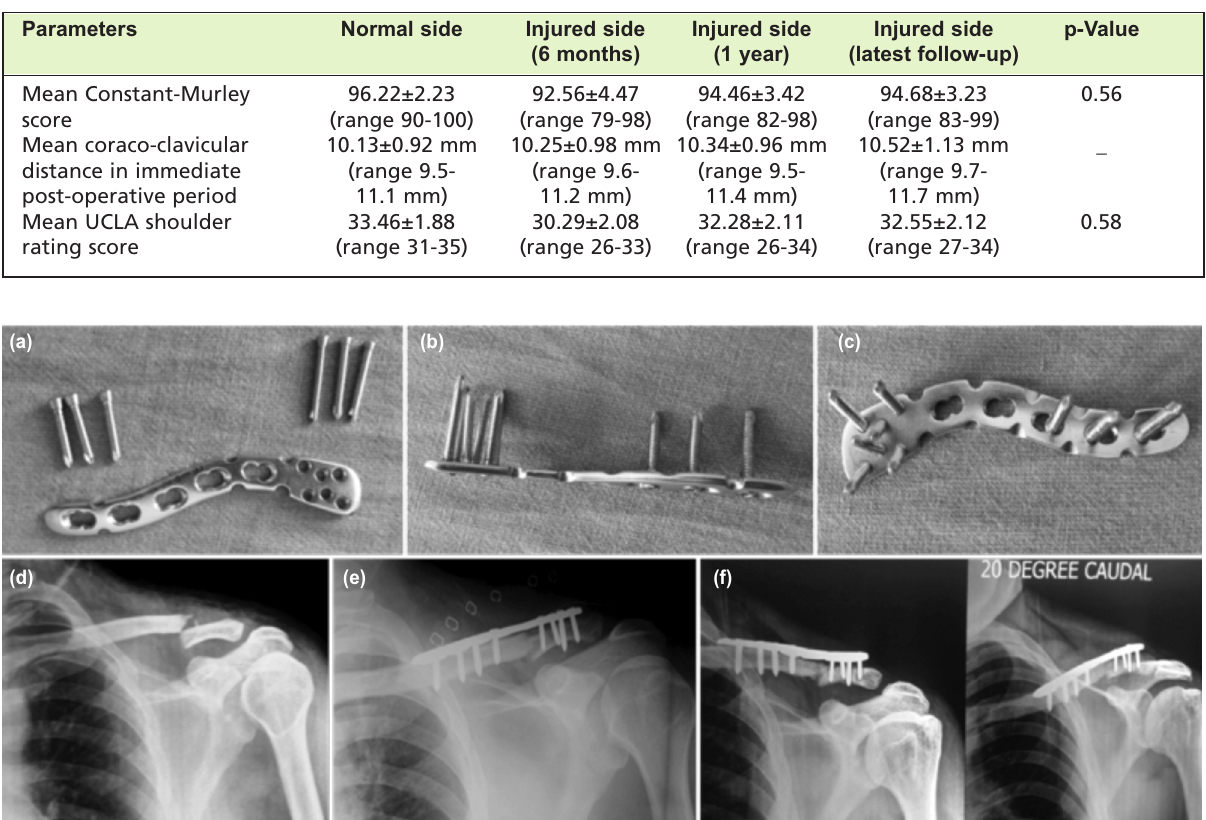
(a) Pre-contoured clavicular locking plate with broad lateral end along with small and large sized screws from superior surface, Fig. 1: (b) from lateral surface, (c) from ventral surface, (d) Antero-posterior (AP) radiograph of shoulder joint showing lateral third clavicle fracture, (e) Immediate post-operative radiograph after fixation with locking plate and (f) AP and 20 degrees caudal view of clavicle 9 months after surgery showing union of